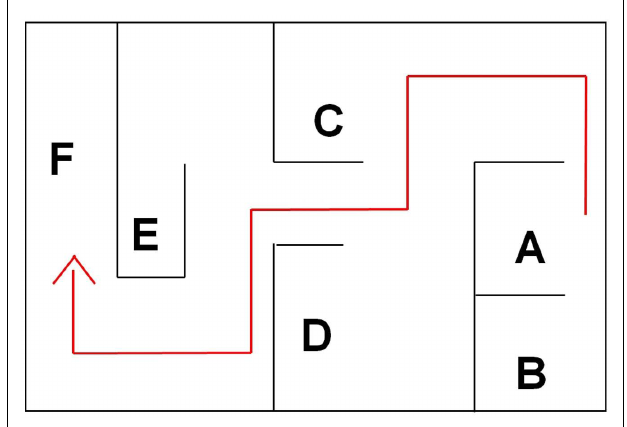
FIGURE 2 |The water maze apparatus and its different zones, coded as follows: (A) entry zone; (A–E) blind alleys (error zones); (F) exit